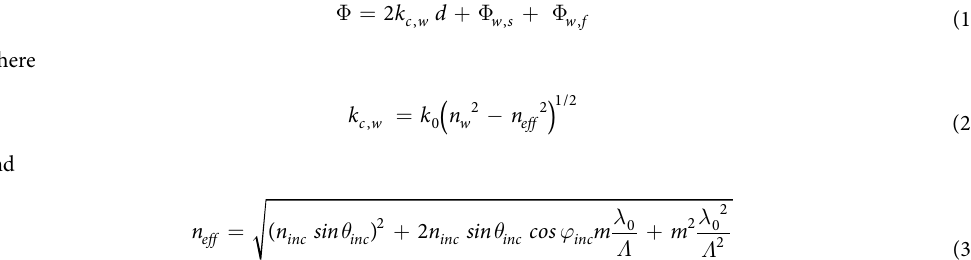
) is measured in r